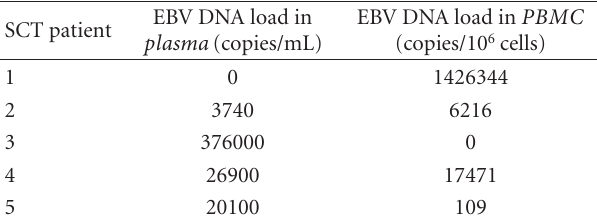
Figure 3: EBV RNA expression analysis in follow-up PBMC samples from two SOT recipients in relation to EBV DNA load kinetics. Viral load in whole blood was monitored by quantitative PCR after solid organ transplantation. Presence of BARTs, EBNA1, LMP1, and 2 RNA was analysed by RT-PCR in 10 6 PBMCs at the indicated time points. Table 2: EBV DNA load determination by LightCycler PCR in simultaneously collected plasma and PBMC samples of 5 representative SCT